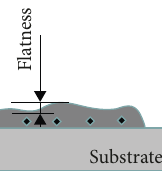
Figure 3: The surface flatness and hardness indentation of the cladding layer. Table 5: Variance analysis of the porosity area of the cladding